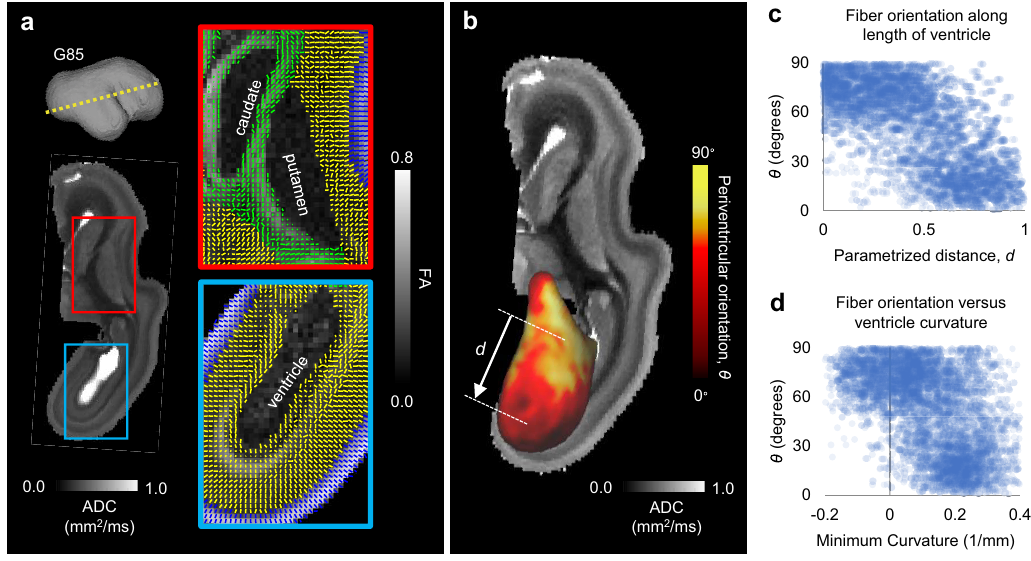
Fig. 7 Primary anisotropy orientation near the ventricular surface in the G85 rhesus macaque brain. a Primary eigenvector directions (tick marks) based on high-resolution DTI of the rhesus macaque ( Macaca mulatta ) brain at G85, at the slice indicated by the yellow dotted line. An apparent diffusion coef fi cient (ADC) map is shown to visualize deep gray matter structures. Red and blue insets illustrate primary eigenvector directions surrounding solid internal brain structures (red) and the fl uid- fi lled lateral ventricle (blue), with fractional anisotropy (FA) maps as an underlay. b The periventricular orientation angle, θ , was calculated and projected to the ventricular surface following the same process described in Fig. 5a. ADC map is again shown to visualize surrounding structures. c For each vertex on the ventricular surface, parameterized distance ( d ) from the approximate center of the long axis of the ventricle was calculated, ranging from 0 to 1. Scatter plot illustrates the relationship between parameterized distance from center, d , and θ . d Minimum curvatures were also calculated at each point, ranging from approximately zero near the center of the long axis of the ventricle to approximately 0.2 mm − 1 near the end of the ventricle. Scatter plot illustrates the relationship between minimum curvature and θ . Data are presented for the only G85 hemisphere investigated in this study. Data points in panels c – d represent the values at individual vertices along the ventricular surface in panel b (5814 unique